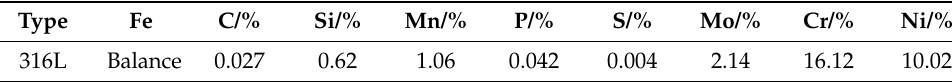
Table 1. Mass fraction of 316L (wt %).